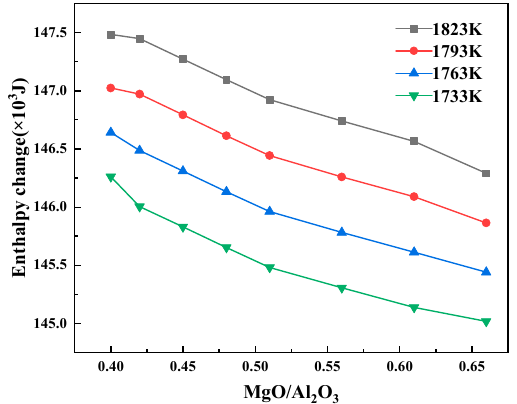
Figure 7. The enthalpy change of slag with varying MgO/Al 2 O 3 .